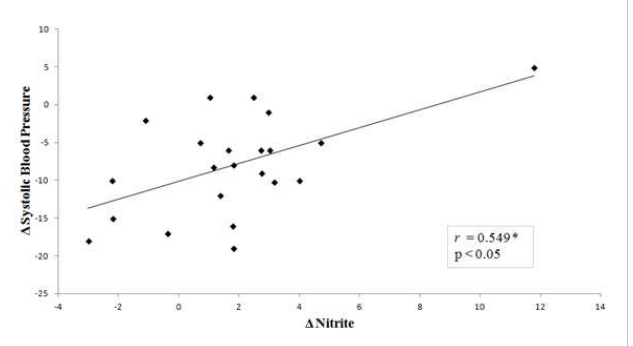
Figure 2. Mean and standard error of nitrite concentration as a marker of NO release at rest, 15 th min (rec15) and 45 th min of post- exercise recovery (rec45) (n=11). S120= exercise session at 120% of lactate threshold; S80= exercise session at 80% of lactate threshold; CON= control session. * p <0.05 in relation to rest.